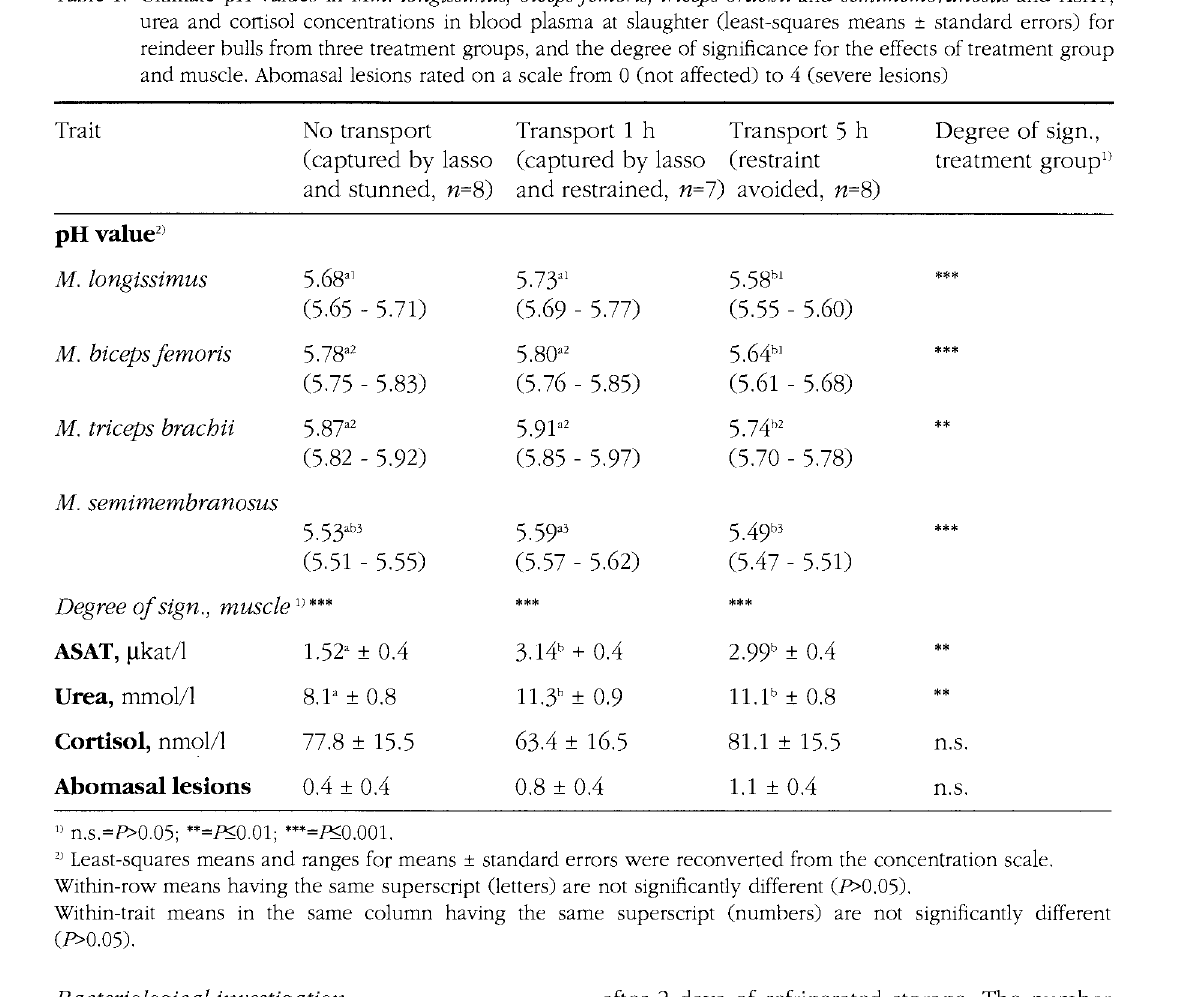
Table 1. Ultimate pH values in Mm. longissimus, biceps femoris, triceps brachii and semimembranosus and ASAT, urea and Cortisol concentrations in blood plasma at slaughter (least-squares means ± standard errors) for reindeer bulls from three treatment groups, and the degree of significance for the effects of treatment group and muscle. Abomasal lesions rated on a scale from 0 (not affected) to 4 (severe lesions) Trait No transport Transport 1 h Transport 5 h Degree of (captured by lasso (captured by lasso (restraint and restrained, w=7) avoided, w=8)